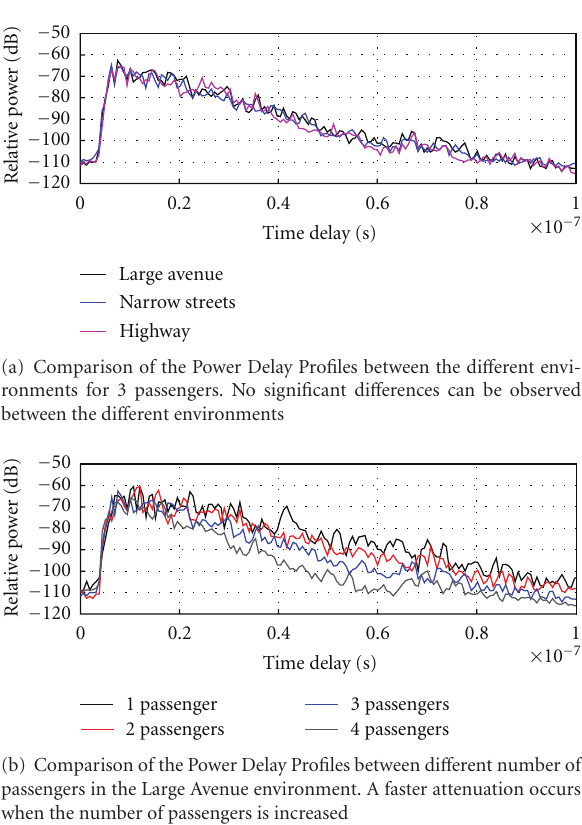
Figure 2: Comparison of the Power Delay Profiles for the di ff erent environments (a) and for di ff erent number of passengers (b).